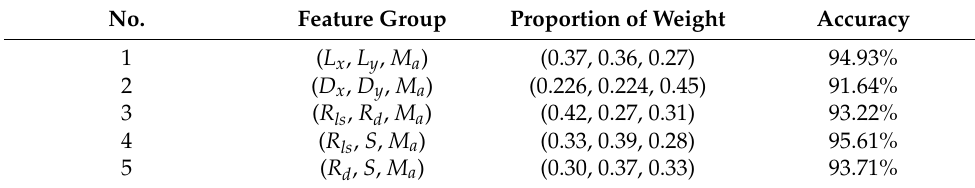
Table 3. The weight percentage of features and the prediction results of feature groups. No. Feature